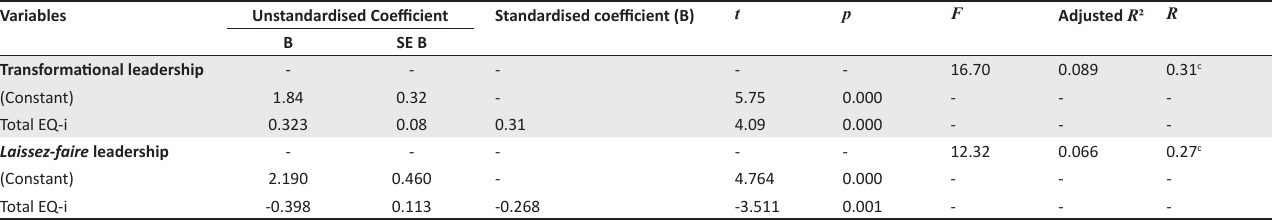
TABLE 4: Summary of standard multiple regression analyses: Total emotional quotient (independent variables) and leadership styles (dependent variables) ( N = 161).